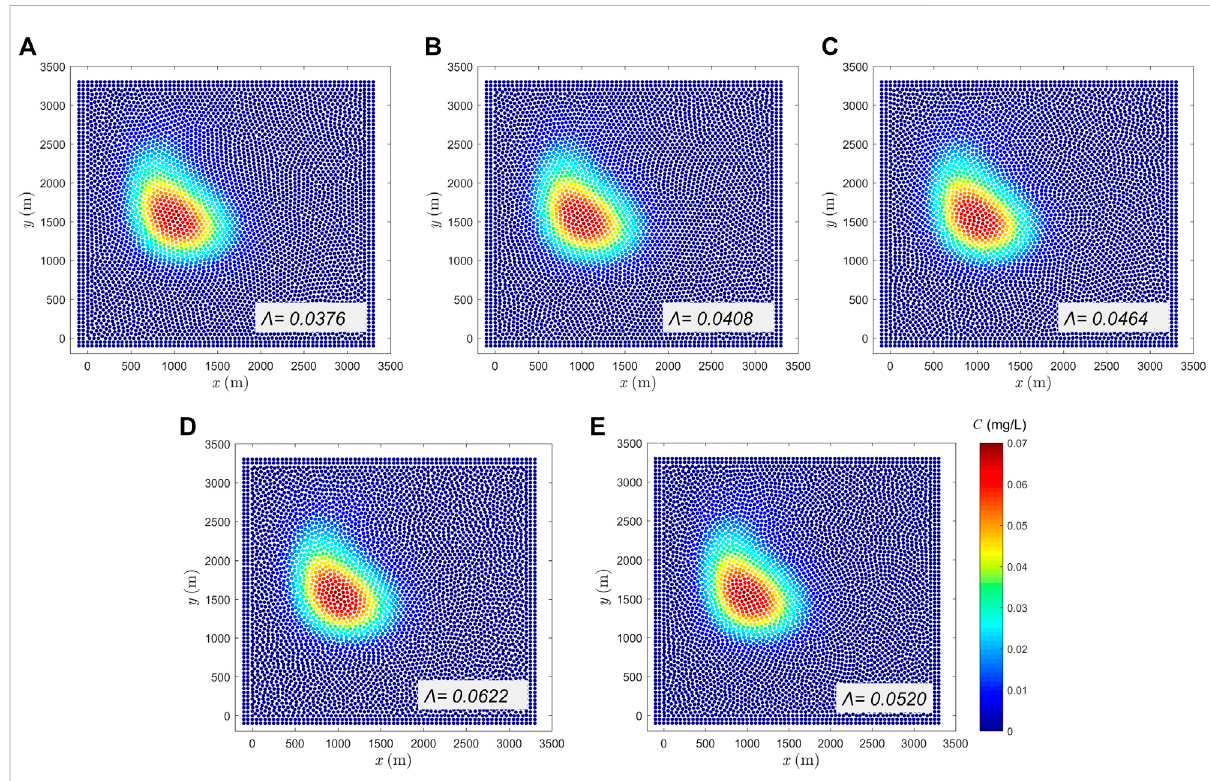
FIGURE 8 SimulationresultsforonerotationbyLind ’ sPSTwithcubicsplinekernelwithRFindifferentsmoothinglength. (A) h =1.1 dx , (B) h =1.2 dx , (C) h =